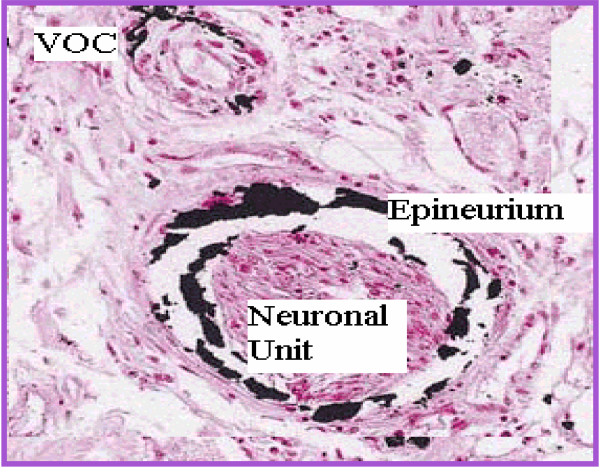
Neuronal calciphylaxis. This image demonstrates not only medial calcification of an arteriole but also calcification of the epineurium of a peripheral neuronal unit within the subcutaneous tissue of a patient with systemic CPLX. This is from the same patient and breast biopsy tissue as in figure 7. Calcium stains black in this von Kossa stain.